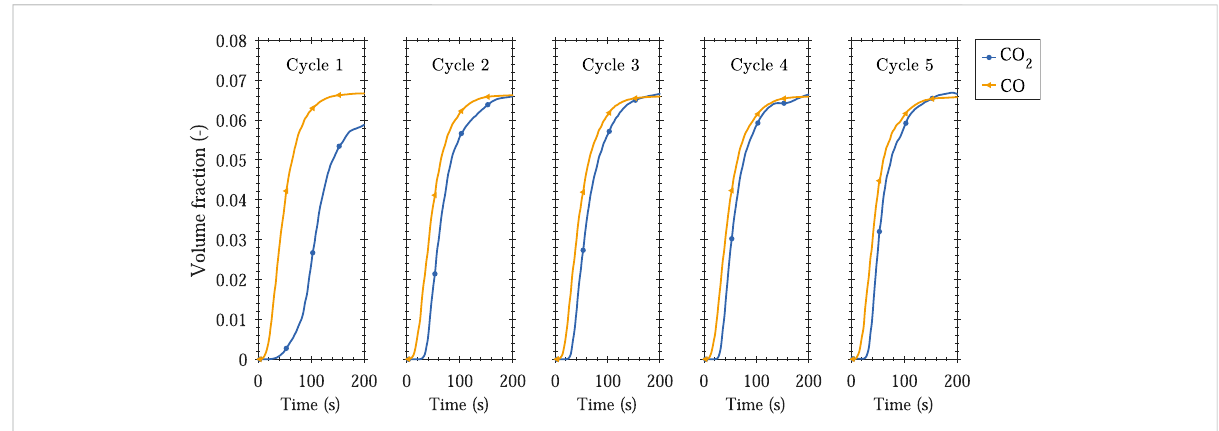
FIGURE 6 Experimental breakthrough curves (dry volume fraction) of CO 2 and CO for the fi rst fi ve adsorption cycles on pure K-HDMO sorbent (no catalyst). CO is shown for comparison. Sorbent mass: 9.70 g, temperature: 250 ° C, pressure: 8 bar, feed composition: 0.05/0.05/0.05/0.2/0.65 CO/ CO 2 /H 2 /H 2 O/N 2 . Regeneration pressure: 1 bar, regeneration feed composition: 0.4/0.6 H 2 O/N 2 .